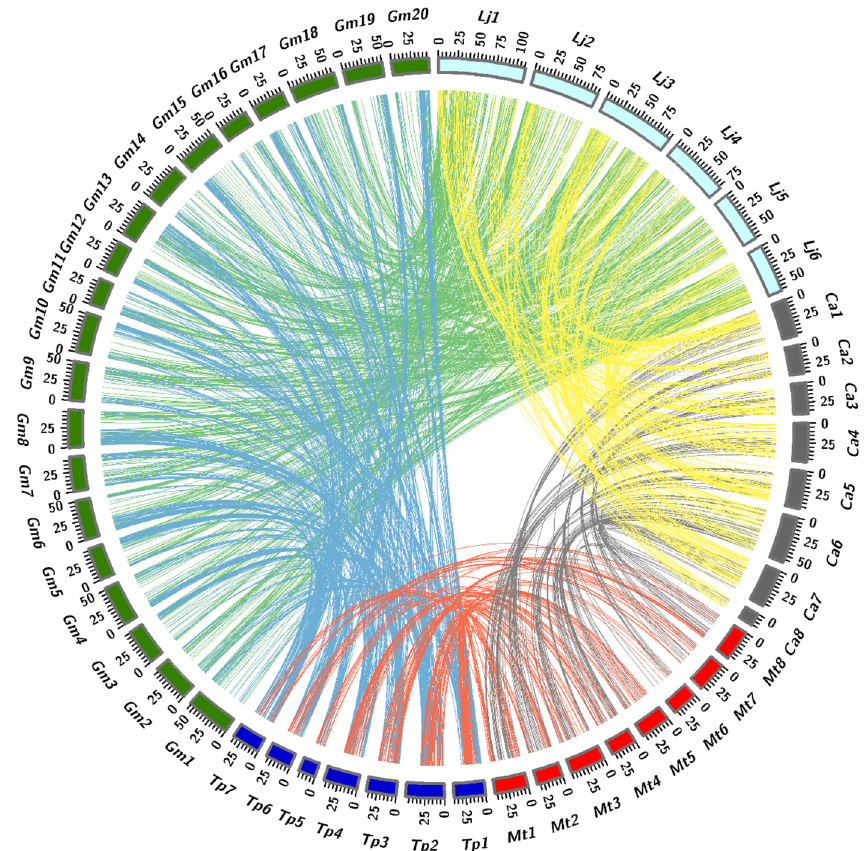
Figure 5. Circos diagram illustrating syntentic relationships between Medicago, Glycine, Lotus, Cicer and Trifolium . Based on phylogenetic analysis comparing the synteny of adjacent species on the phylogenetic tree branch, which show a high degree of synteny.